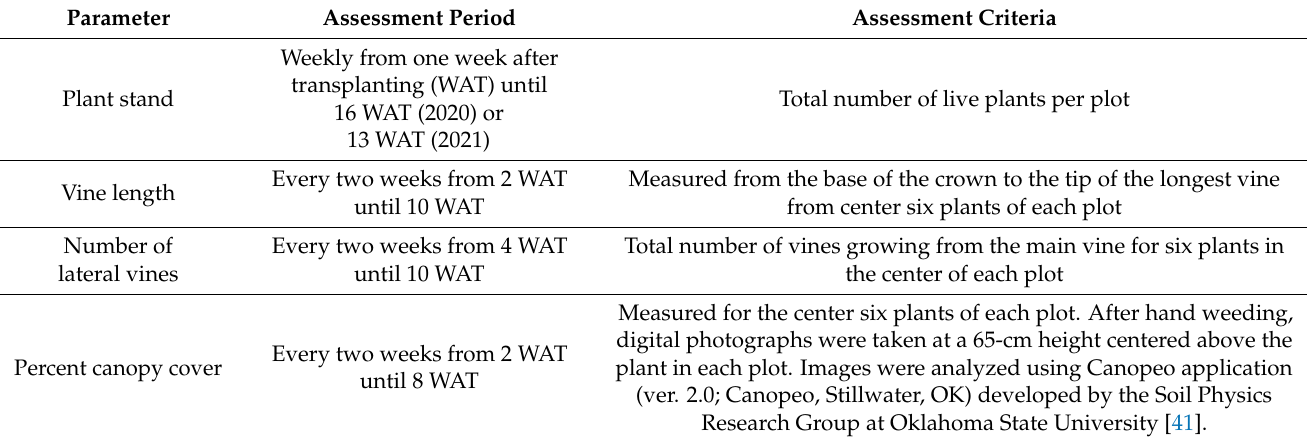
Table 1. Plant growth parameters assessed from field trials conducted at Mount Vernon, WA in 2020 and